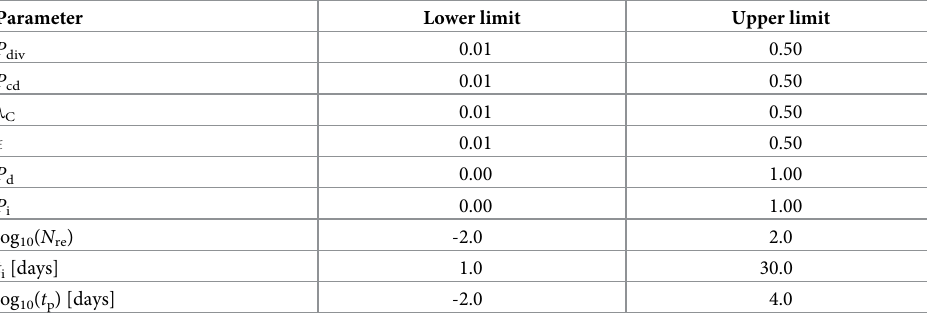
Table 1. Upper and lower boundaries for the model parameters ( Θ ) in the constructed